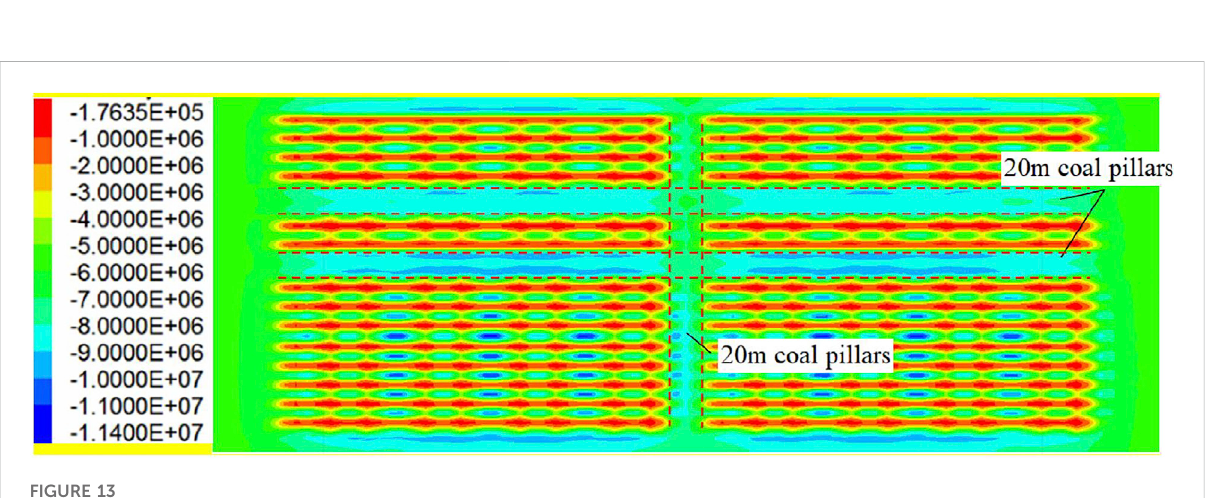
FIGURE 13 Vertical stress distribution of strata at 12m on top of 3# coal seam